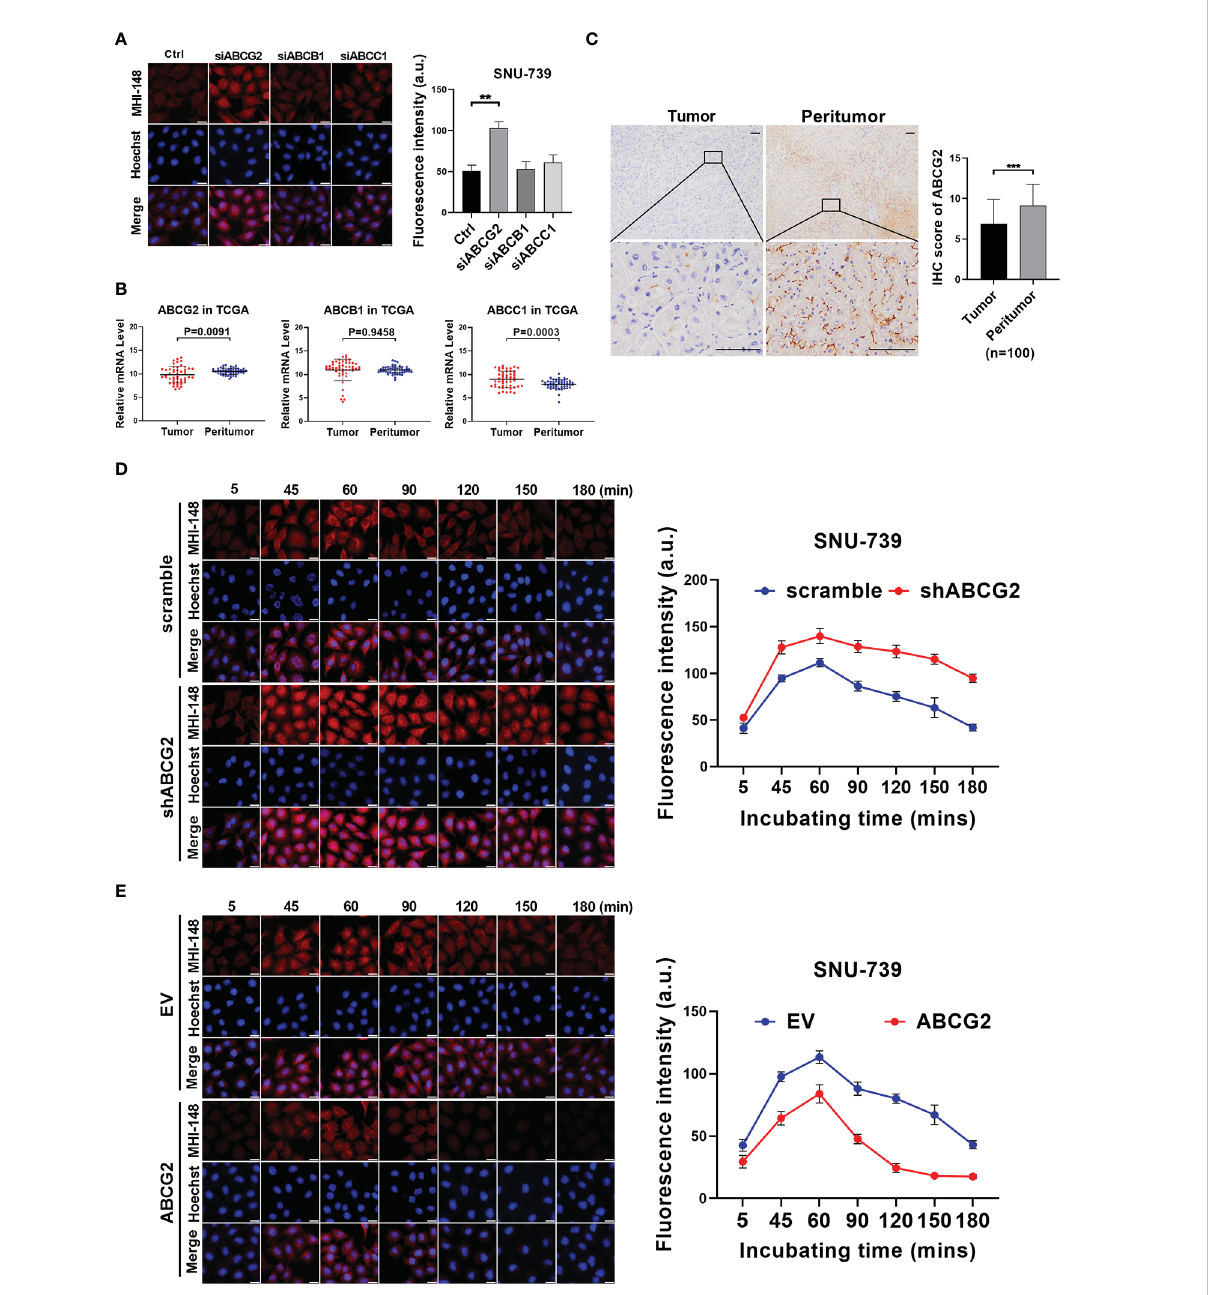
FIGURE 4 The ef fl ux of MHI-148 from HCC cells is mainly mediated by ABCG2 in vitro . (A) Near-infrared fl uorescence imaging of SNU-739 cells transfected with siRNAs against different ABC transporters and stained with MHI-148 for 180 minutes. (B) The relative mRNA expression levels of tumor and peritumor of ABC transporters were analyzed by transcriptome sequencing data from TCGA. (C) Representative IHC staining image (left) and IHC score (right) of ABCG2 in 100 paired HCC tissues (tumor and peritumor). Data are expressed as mean ± SD. Scale bar, 50µm. (D, E) Determination of MHI-148 retention in SNU-739 cells with knockdown or overexpression of ABCG2. Data shown are the mean ± SD from three independent experiments, where appropriate. **P < 0.01; *** P<